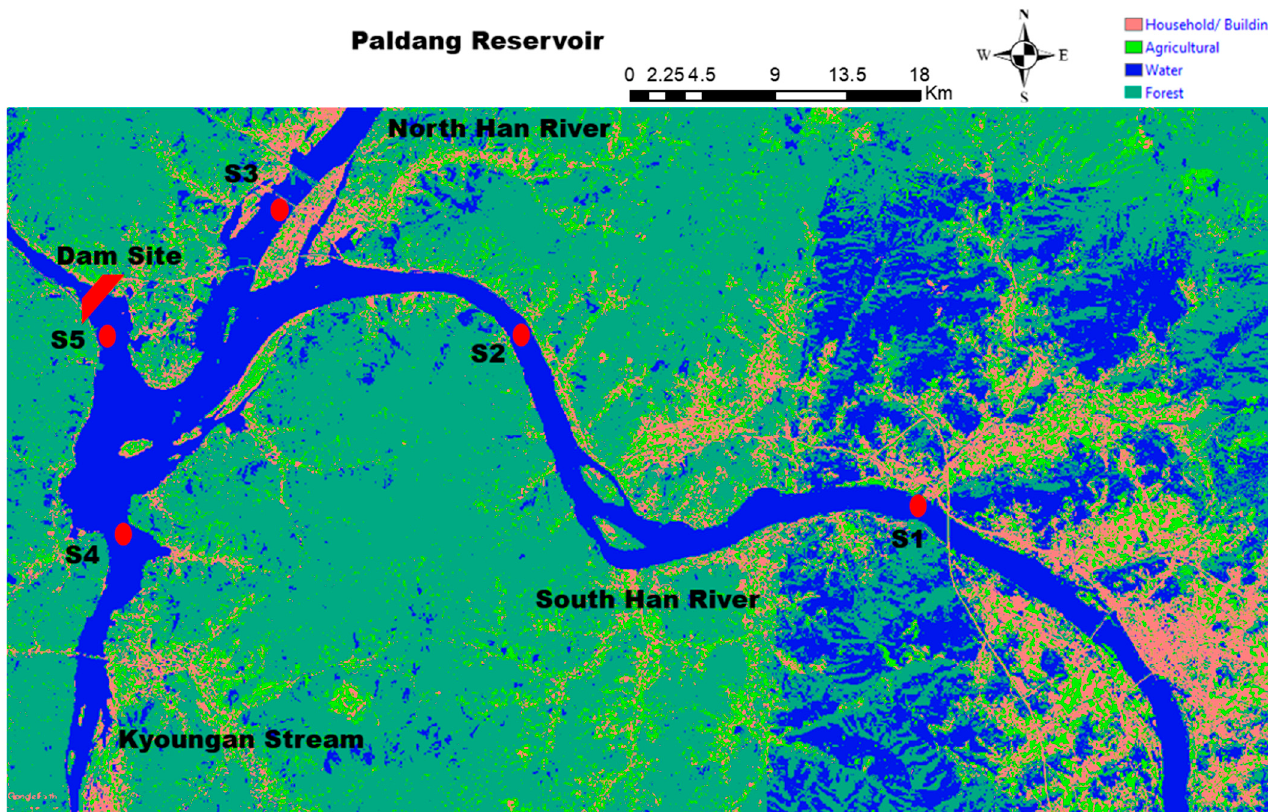
Figure 1. The map showing the sampling sites of Paldang